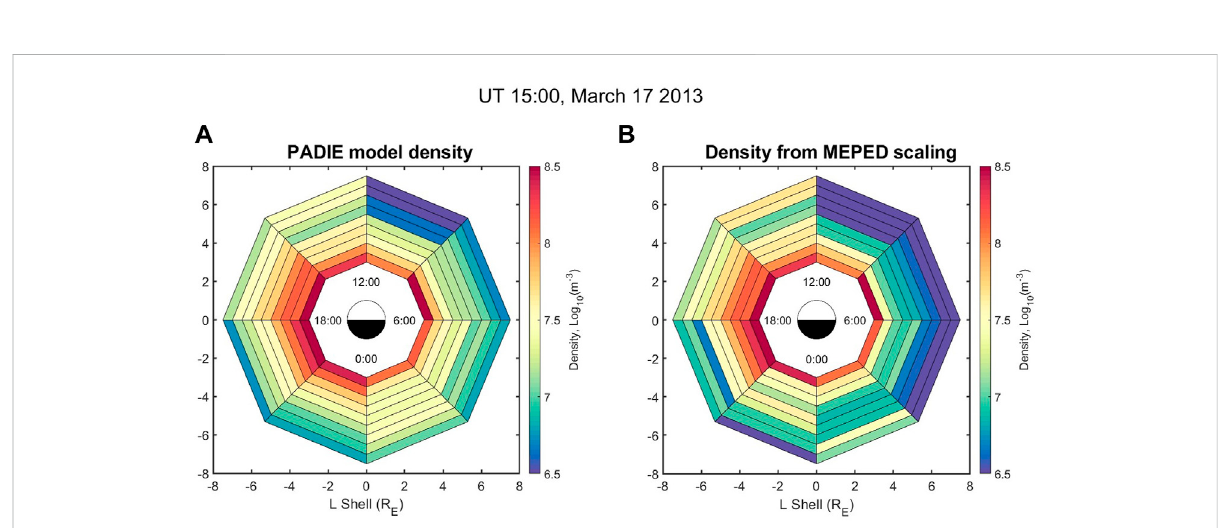
FIGURE 7 Snapshot of equatorial density. Plot (A) shows the statistical density model used to calculate diffusion coef fi cients with PADIE (Meredith et al., 2020).Inplot (B) theinferreddensityisshownfromthenewscalingmethodthatutilizesboththe30 – 100 keVand100 – 300 keVenergyrangesfrom MEPED. A movie showing the inferred density at every time step is included in the supplemental